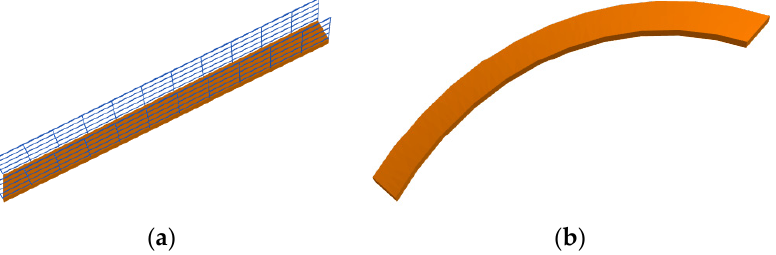
Figure 19. Ramps to be evaluated: ( a ) straight ramp and ( b ) curved ramp.